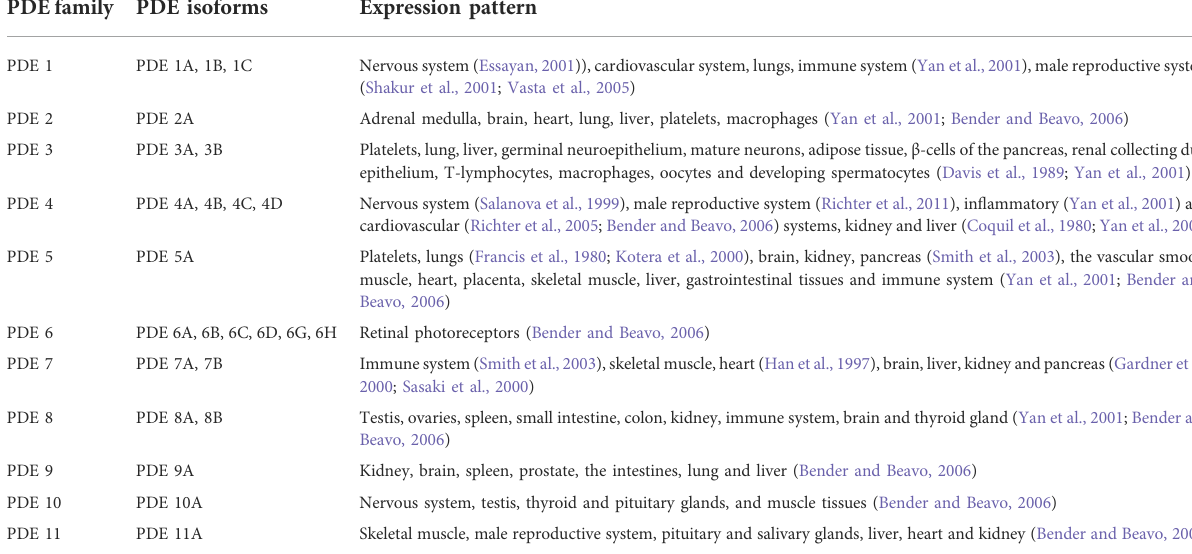
TABLE 1 PDE isoforms and expression pattern. This table provides a summary on the PDE enzymes ’ isoforms and their expression pattern. PDE family PDE